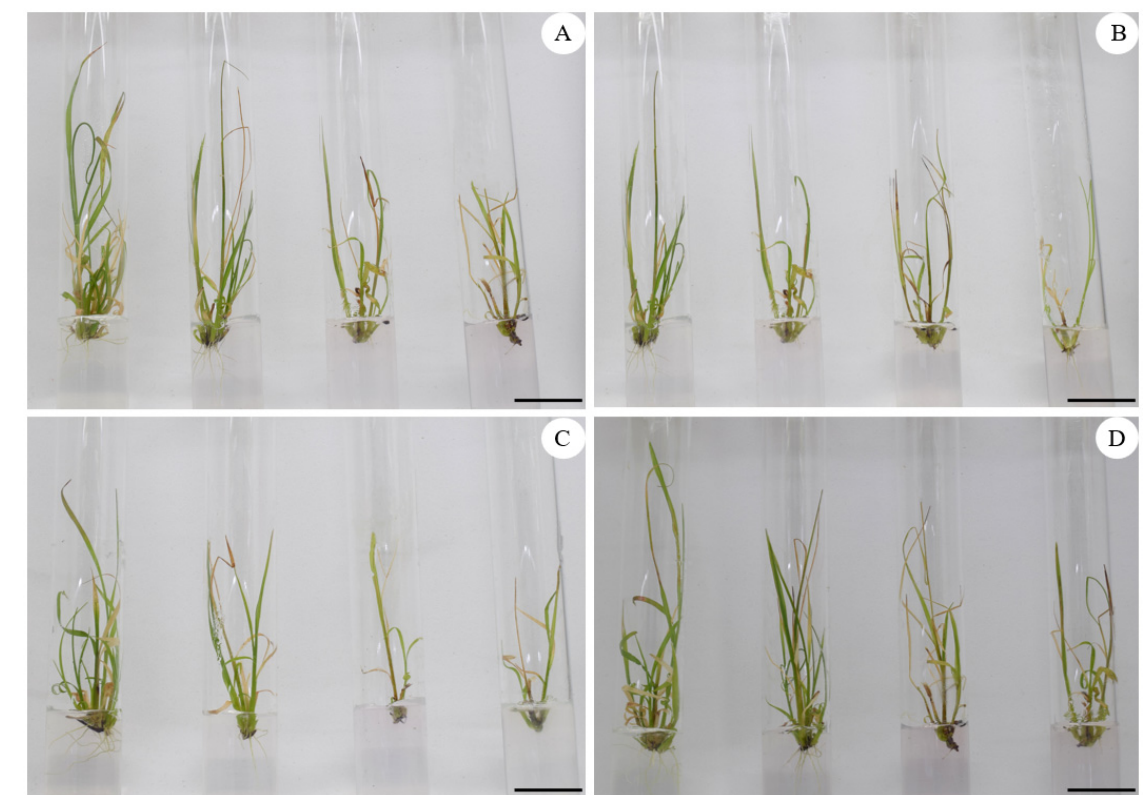
Figure 1. Effect of different concentrations of PEG-6000 (0, 3, 6, and 9%, left to right) on sugarcane cultivars ( Saccharum spp. Hybrids) during in vitro selection. ( A ) Mex 69-290, ( B ) Mex 79-431, ( C ) CP 72-2086 and ( D ) MOTZMex 92-207. Black bar = 2 cm.